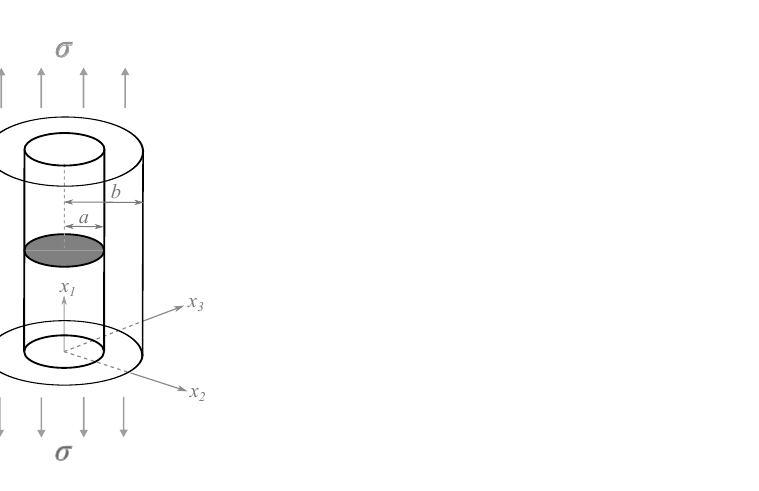
Figure A3. Geometric illustration of a model consisting of a broken fibre embedded in a matrix as a solid cylinder with central circular crack. The fibre is broken in the middle ( x 1 = L /2) and shown as the grey